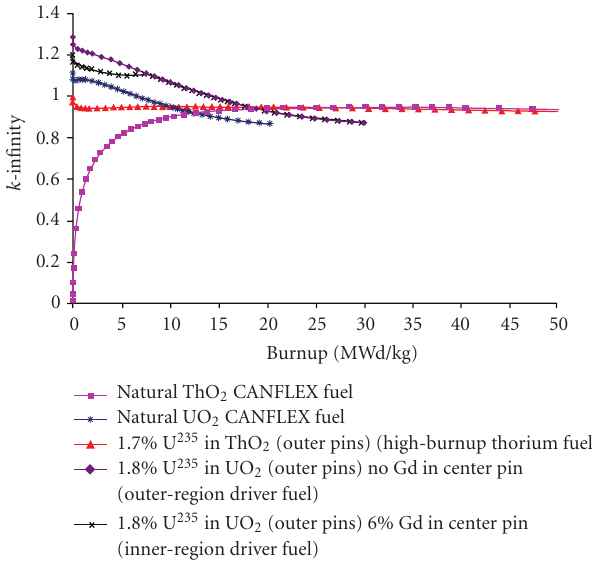
Figure 5: k inf as a function of burn-up in CANDU [8].